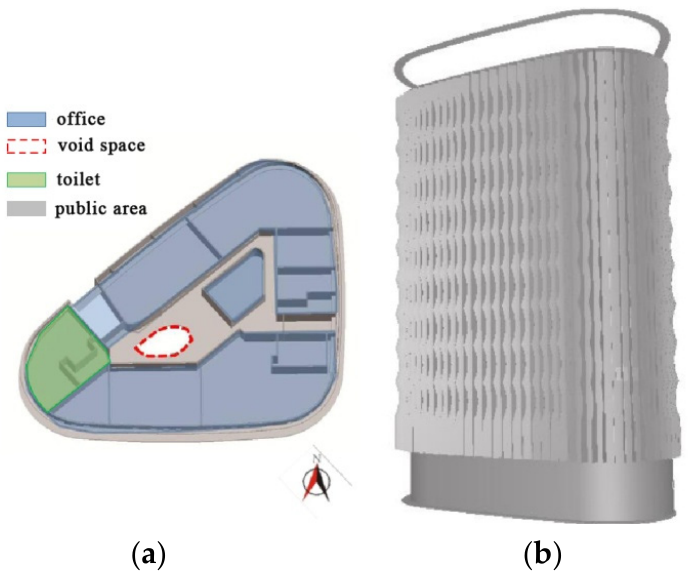
Figure 2. Studied building. ( a )Standard plan. ( b ) Perspective.